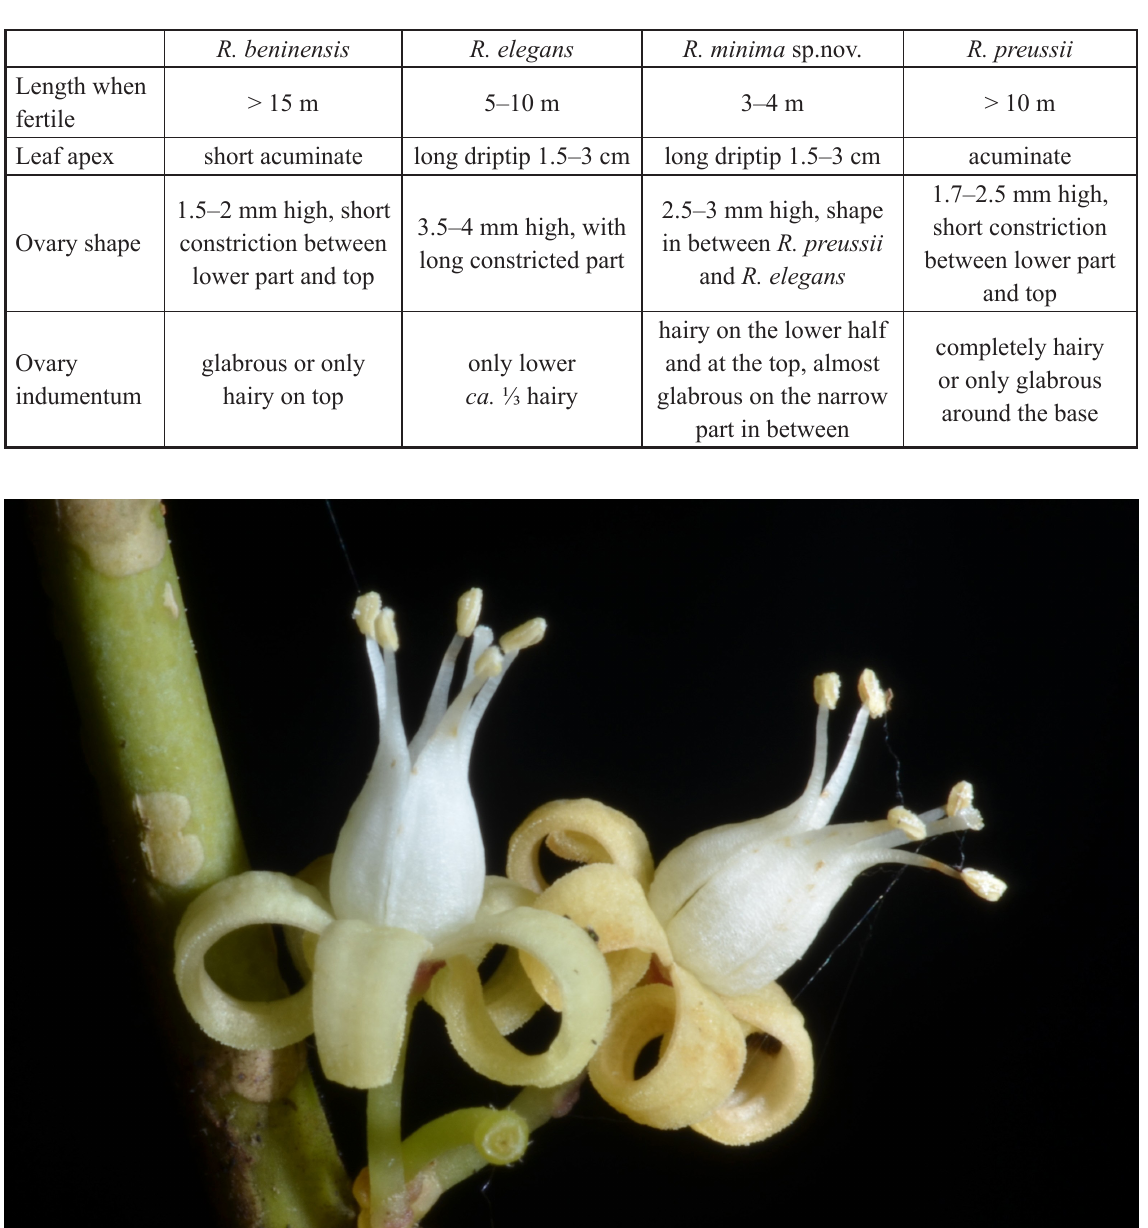
Table 1. Main differences between Rhaphiostylis beninensis , R. elegans , R. minima sp. nov. and R. preussii .